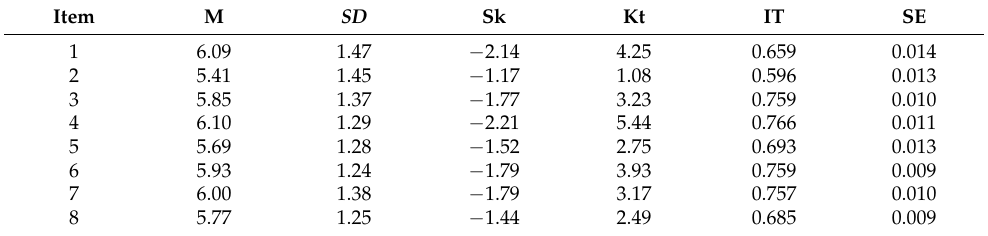
Table 2. Statistics of the items of the Flourishing Scale and corrected item-total polyserial